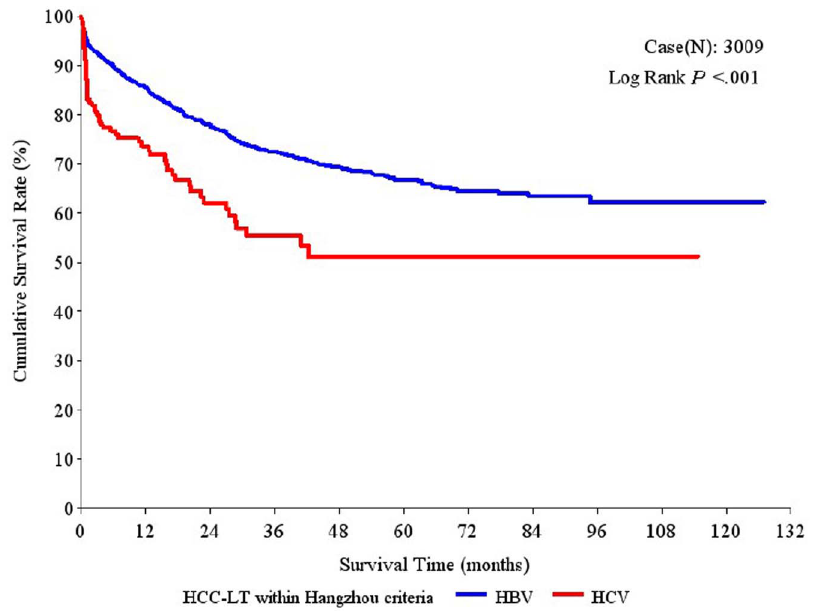
Figure 4. Hepatitis-free survival rates after liver transplantation (LT) in patients with hepatitis B virus (HBV)-associated hepatocellular carcinoma (HCC) and hepatitis C virus (HCV)-associated HCC who met the Hangzhou criteria.